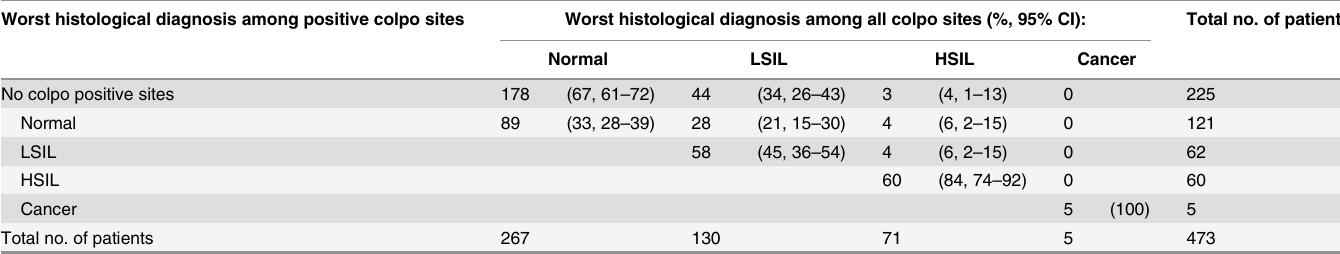
Table 4. Comparison of worst histological diagnosis among sites diagnosed as positive by colposcopy with worst overall histological diagnosis for the 473 Houston diagnostic patients. Worst histological diagnosis among positive colpo sites Worst histological diagnosis among all colpo sites (%, 95%